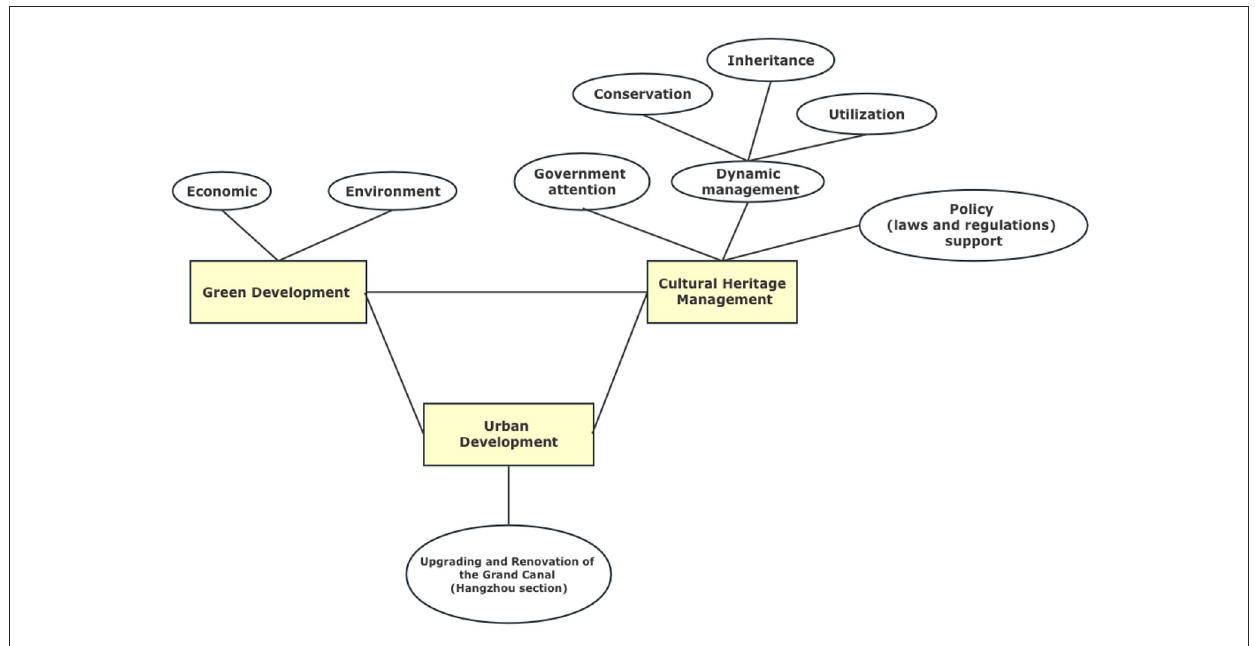
FIGURE1 Research